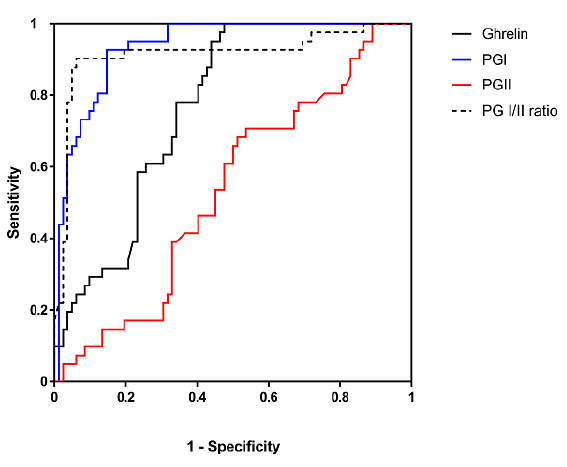
Figure 3: Receiver Operating Characteristic (ROC) curve for ghrelin, PG I, II, and PG I/II ratio for screening of gastric